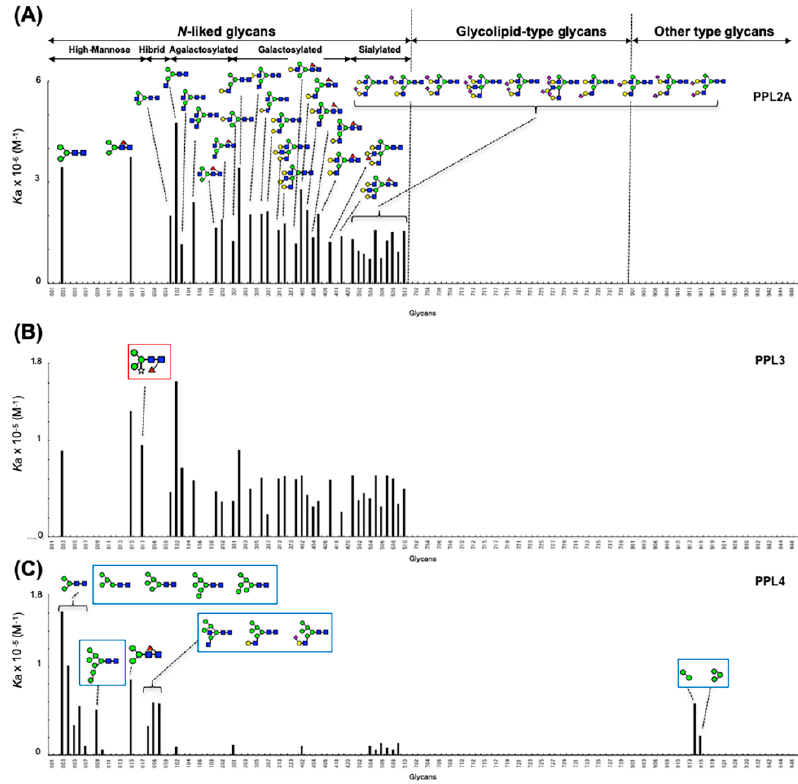
Figure 4. Bar graph representation of a ffi nity constants ( K a ) of PPL2A ( A ), PPL3s ( B ), and PPL4 ( C ) toward N-linked glycans, glycolipid-type glycans, and other glycans. Small Arabic figures at the horizontal axes correspond to sugar numbers indicated in Supplementary Materials Figure S6, which are classified into high-mannose-type, hybrid-type, agalacto-type, galactosylated-type and sialylated-type N-linked glycans, glycolipid-type glycans, and others. Glycans in red and blue boxes are those showing the di ff erent specificities for PPL3s and PPL4, respectively, compared with